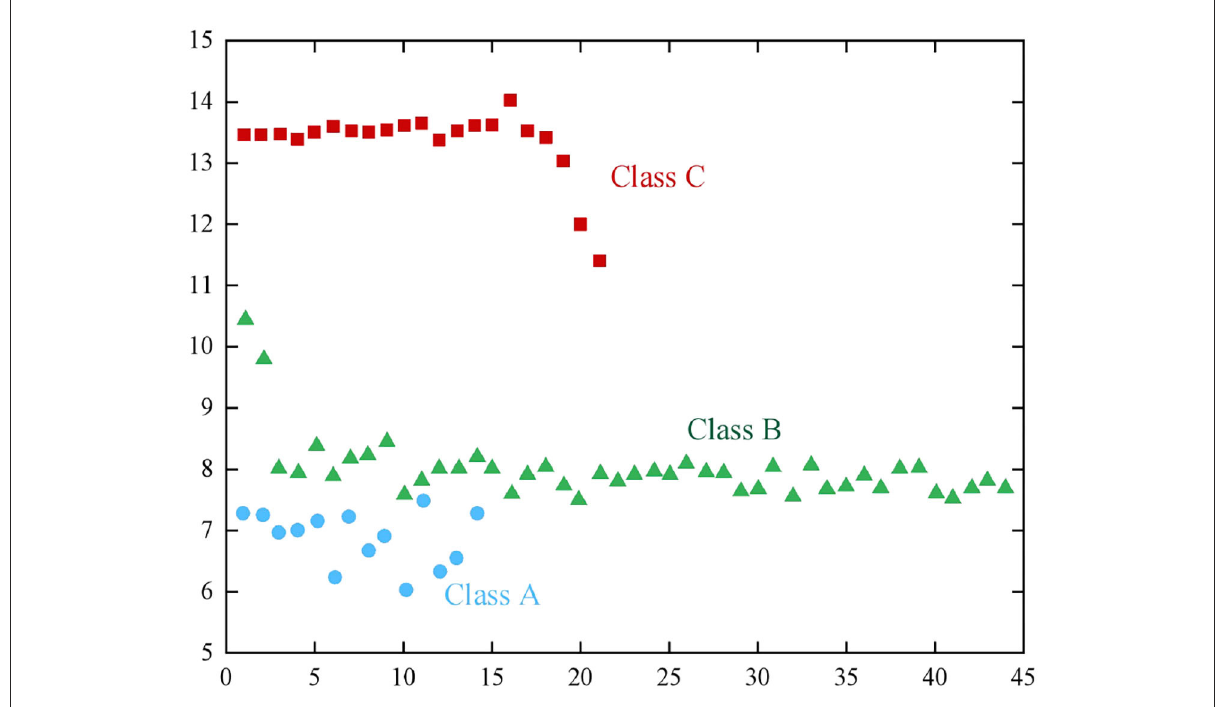
FIGURE5 The clustering results of pH values of seawater.